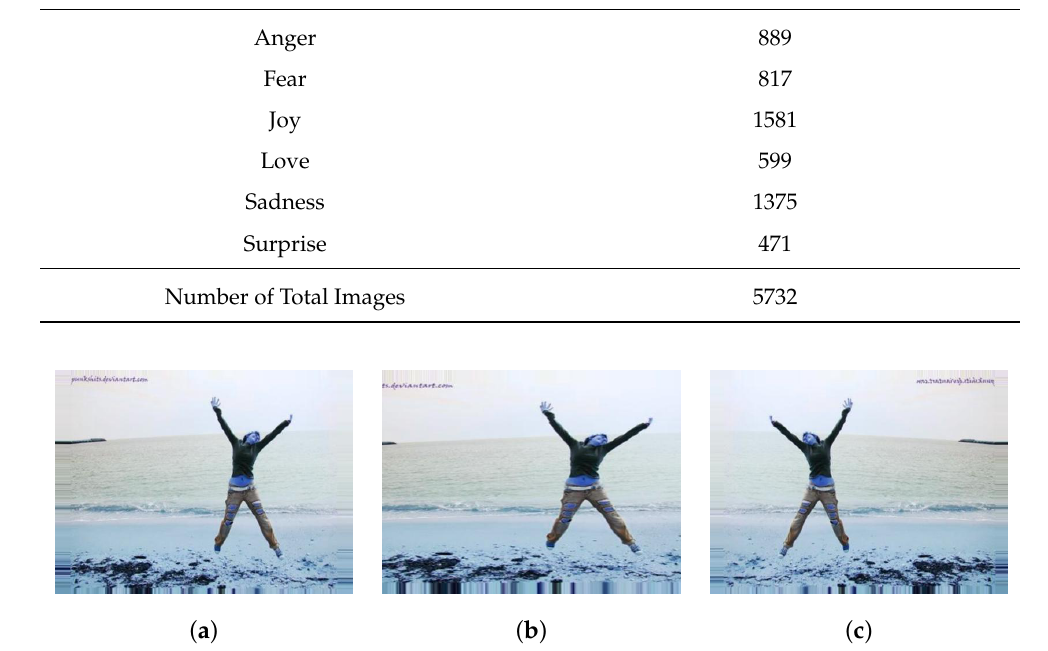
Figure 6. Data Augmentation: ( a ) original; ( b ) scale; ( c ) flip.